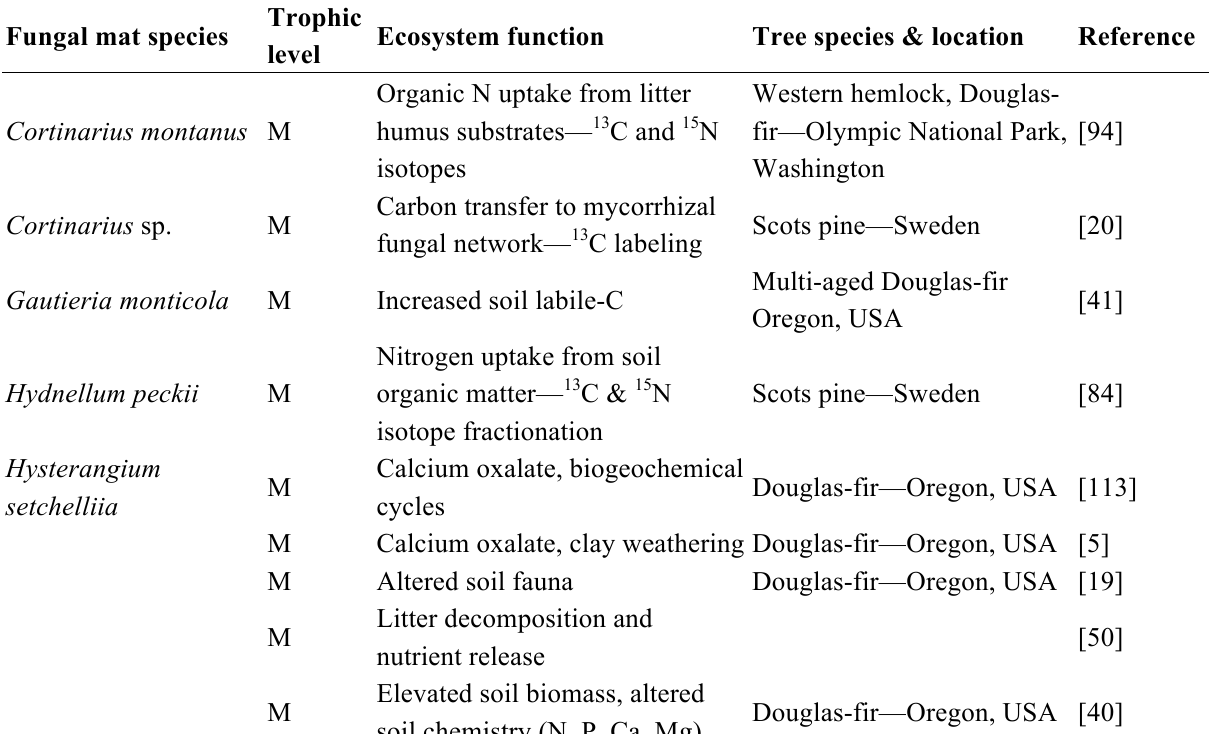
Table 5 . Representative fungal species from Crater Lake National Park that have been used in studies of mat functions in forest ecosystems. Trophic level: M = mycorrhizal, S =